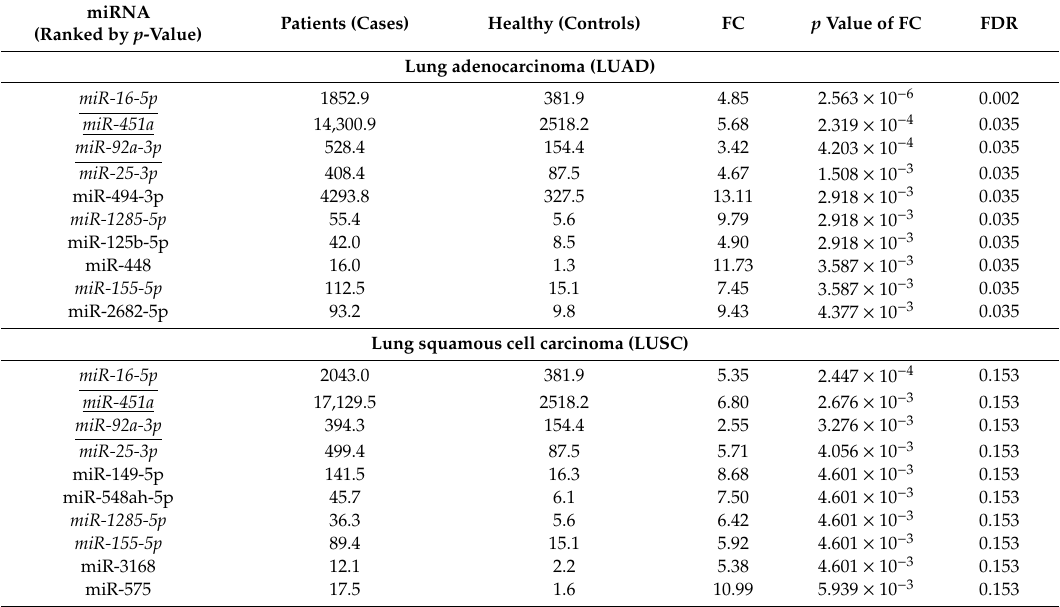
Table 1. Top 10 miRNAs with high levels in patient plasma, by statistical significance.